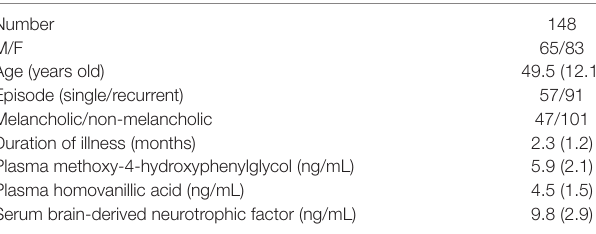
TaBle 1 | Demographic data of the